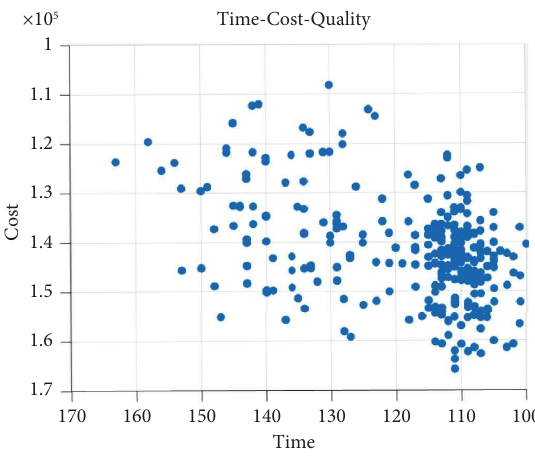
Figure 15: Time-cost